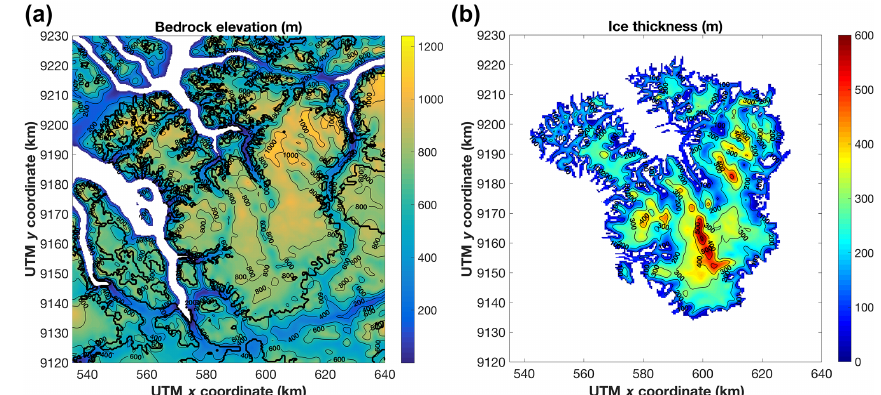
Figure 2. (a) Bedrock elevation (Starzer and Reeh, 2001). Areas below sea level (fjords with semi-permanent sea ice) are depicted in white; the thick black line corresponds to the outline of the observed glaciated area. (b) Ice thickness in the mid-1990s based on the DEM from Starzer and Reeh